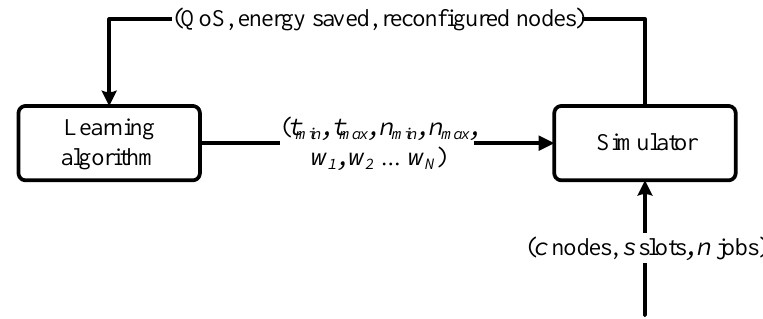
Figure 3. EECluster learning process. QoS: Quality of